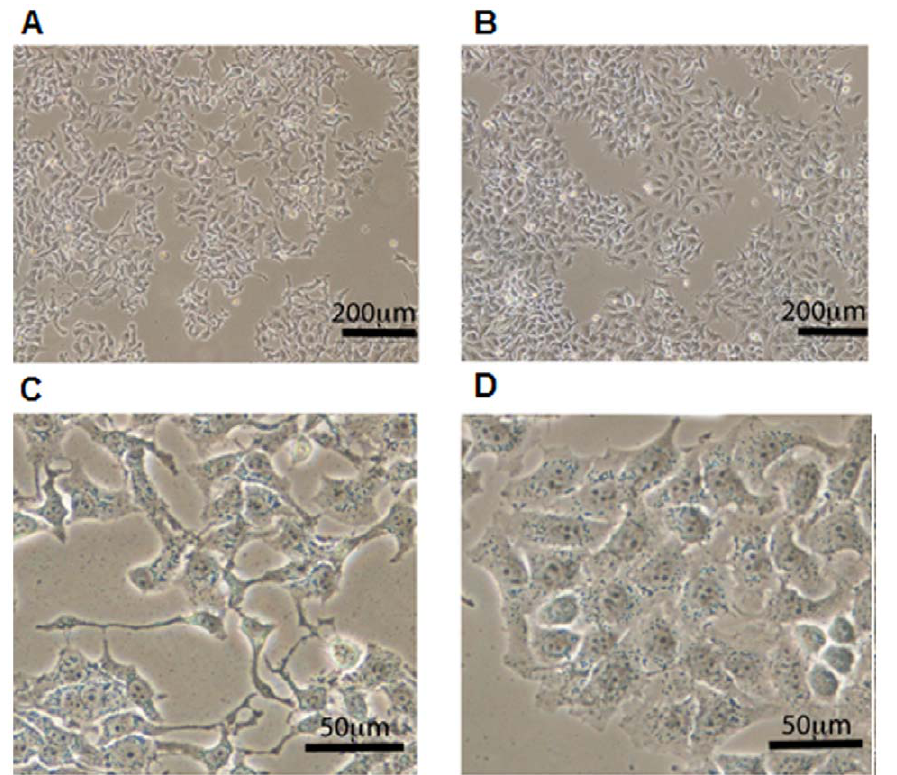
Figure 6. Effect of PS-modified SL 2 –B aptamer sequence compared to the scrambled sequence on Hep G2 cells. Low magnification view of (A) modified sequence treatment, (B) scrambled sequence treatment on Hep G2 cells after 72 hours under hypoxia condition. Scale bar=200 m m. Close up views of (C) modified sequence treatment, (D) scrambled sequence treatment on Hep G2 cells after 72 hours under hypoxia condition. Cellular morphology differs upon the different treatments; modified sequence treatment produces cells which are thinner with more cellular projections while the scrambled sequence treatment shows cells which appear closer to the untreated Hep G2 cells. Scale bar=50 m m.